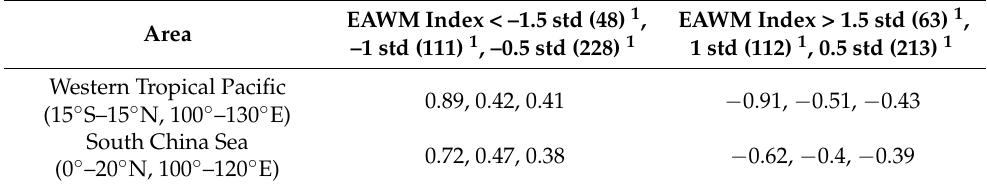
Table 1. Area-averaged precipitation anomaly (mm day − 1 ) related to the intraseasonal variation of the